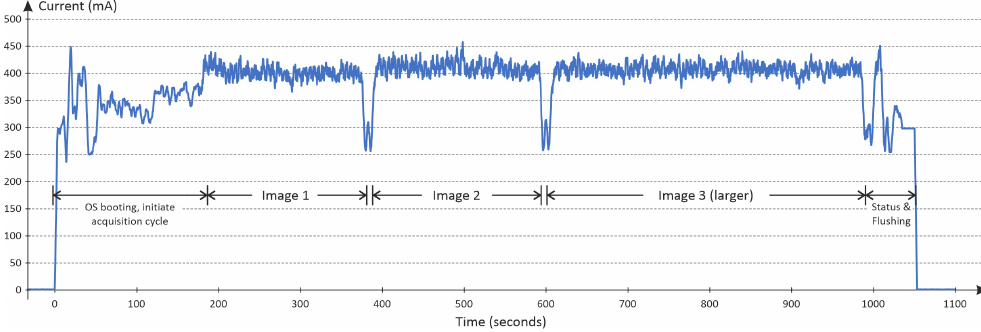
Figure 14. VineInspector common operation power consumption profile over a 18 min